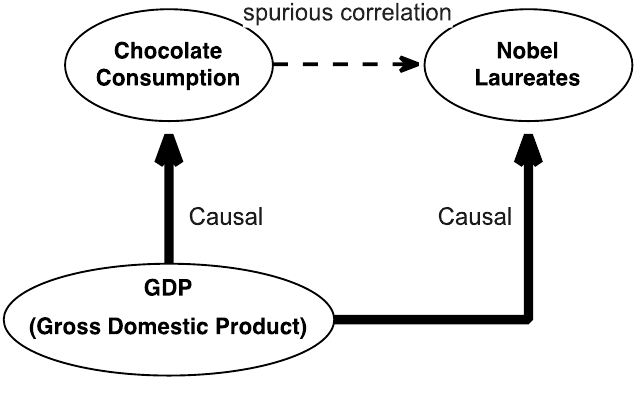
Fig. 1. Example causal-effect relationships among chocolate consumption, Nobel laureates and